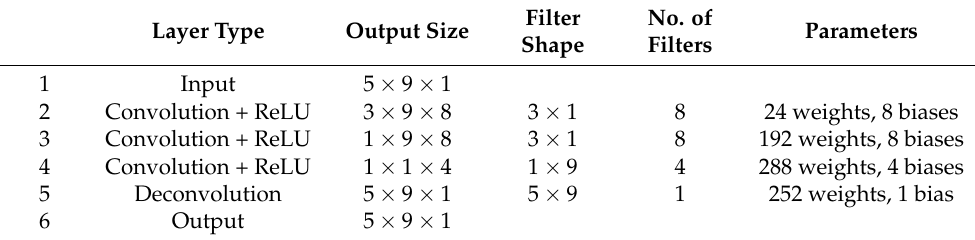
Table 7. CAE network parameters in the investigated CAE